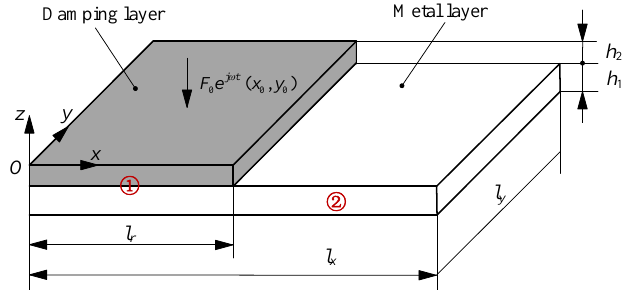
Figure 2. A plate with PFLD treatment under a concentrated harmonic load. Figure 3 is the power transmission relation between subdomains with and without q i − free layer damping treatment. q i + ( i = 1, 2) are energy intensity of bending f f